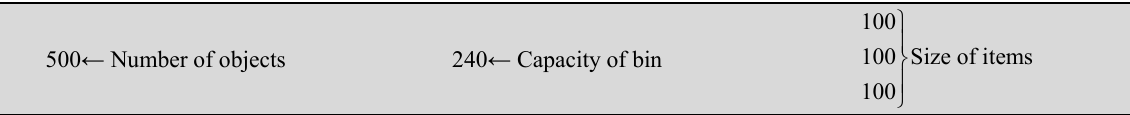
To evaluate the performance of all the variants of harmony search, this paper uses mean, standard deviation and best where best is the most converged solution in the harmony memory. Suganthan et al. (2005) presented six metrics for evaluating the performance of the algorithms. These six parameters are namely convergence graph, average number of function evaluations (NFEs), success rate (SR), acceleration rate (AR) and improvement. Parameters are calculated using the following equations.